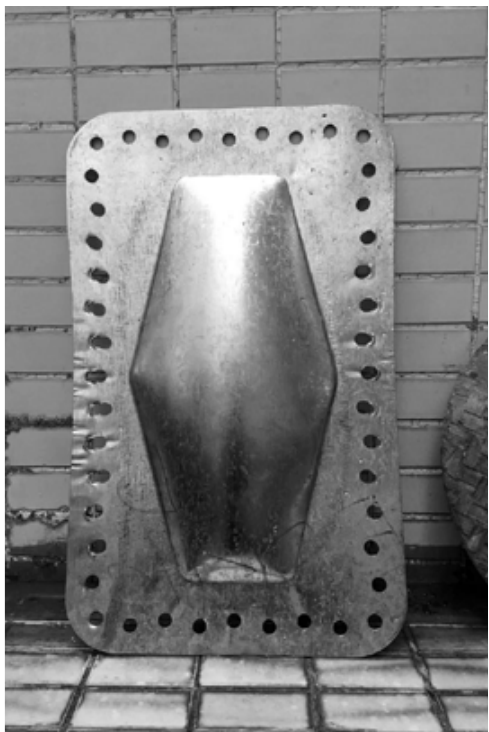
Figure 1 (top, opposite page): Early free-pressure forming test. This test successfully removed welding from the workflow, a desirable change for application to galvanised, anodised, or otherwise pre-coated metals that make welding dangerous or impossible. However, the through-bolted attachment flange on the rear of this test is not removable without destroying the final fabrication. Source: author. Figure 2 (bottom, opposite page): Modified marine scupper plug, allowing demountable water pressure supply for free pressure forming. A rubber gasket adhered to the edges of a hole allows inflation of the metal volume without trapping the water supply attachment inside. To reduce the size of the entry aperture requires a custom attachment,